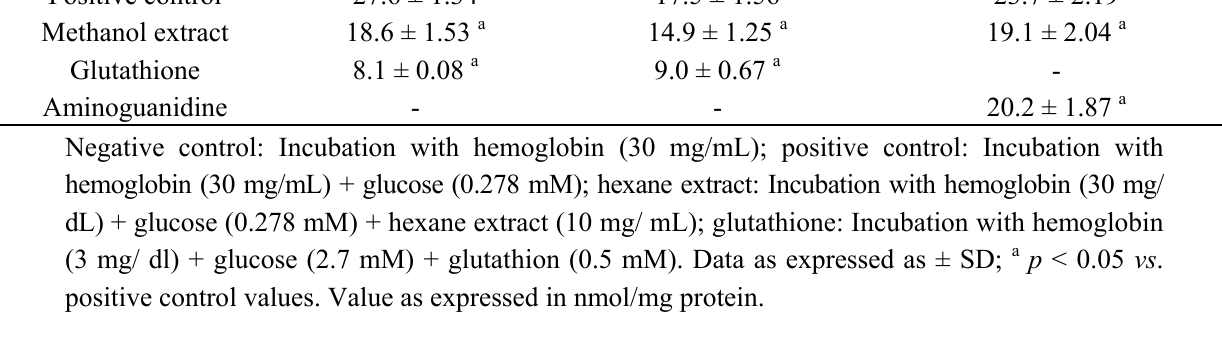
Table 5. The prooxidant effect of amphotericin B (AB) at 5 and 10 µM, and the antioxidant protection of 5 µM HS against 10 µM, AB-induced malondialdehyde (MDA) formation after a 48-h incubation at 37 °C.